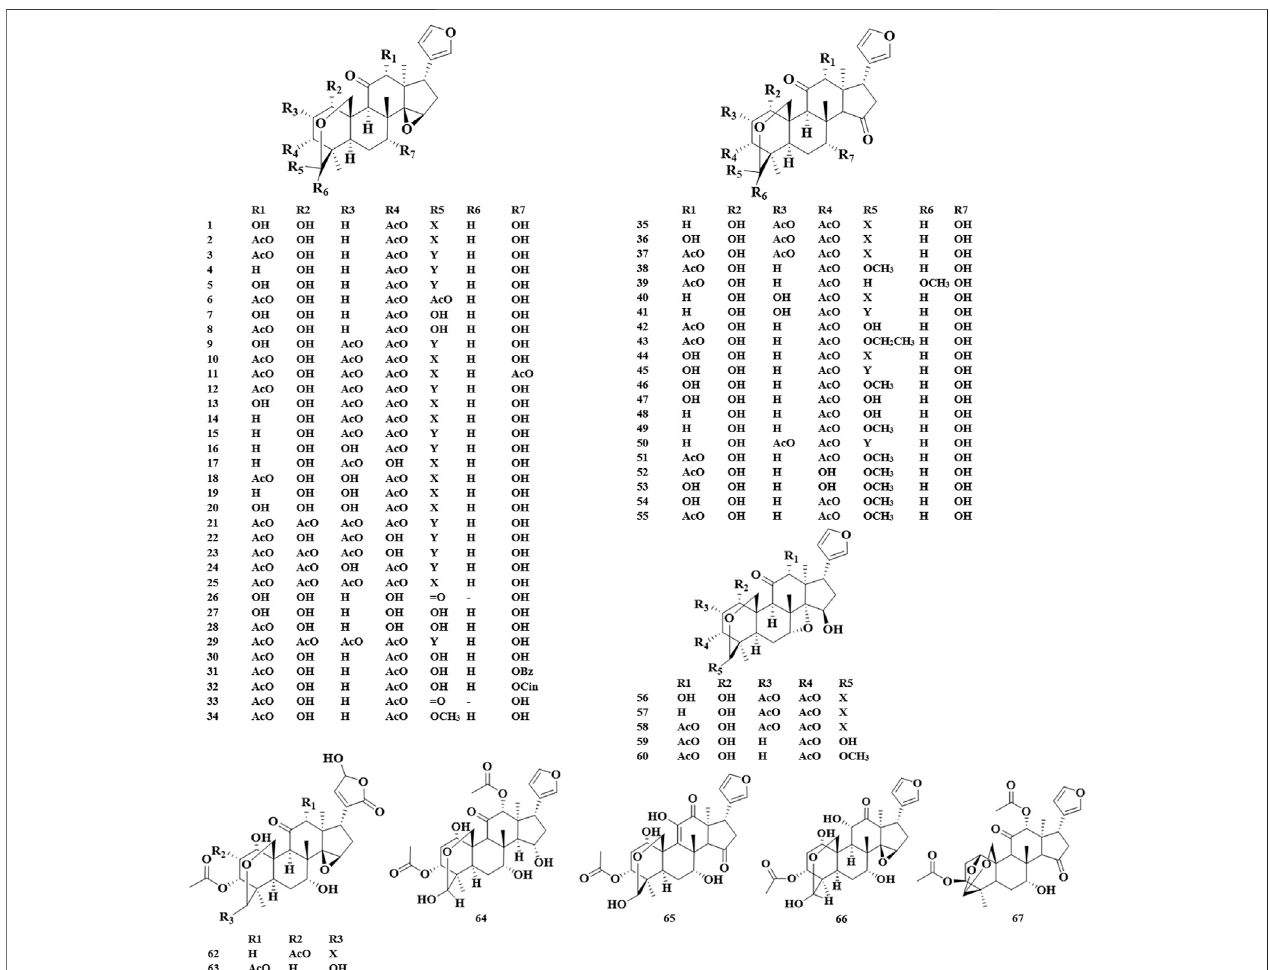
FIGURE 2 | Structures of trichilin class limonoids 1 –